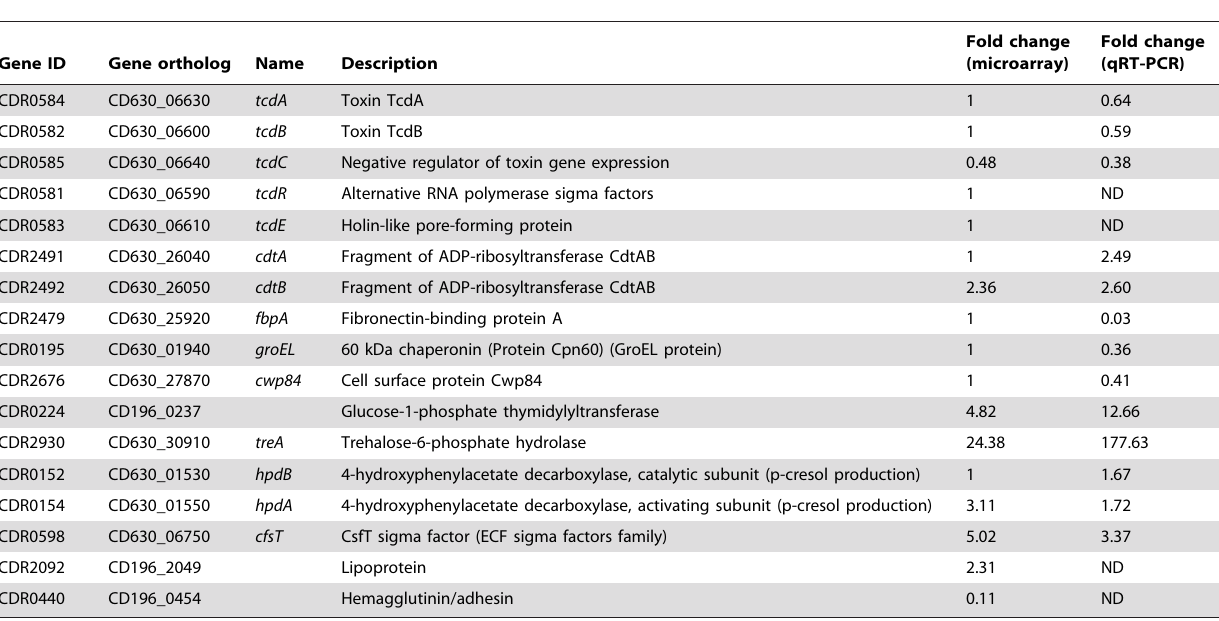
Table 4. Known and putative virulence factor genes differentially expressed in vivo i n the fliC mutant compared to strain R20291.